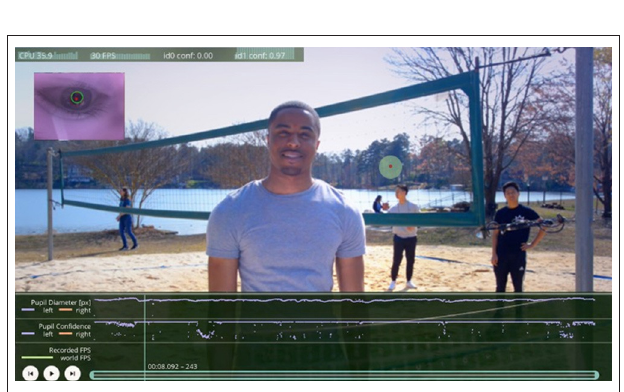
FIGURE 7 | Emory Multimodal Memory Test. A new multimodal tool that is under development for the assessment of multiple domains of cognition and their integration, along with simultaneous recorded eye position and pupil diameter data. Written informed consent was obtained from the individual for the publication of any potentially identifiable